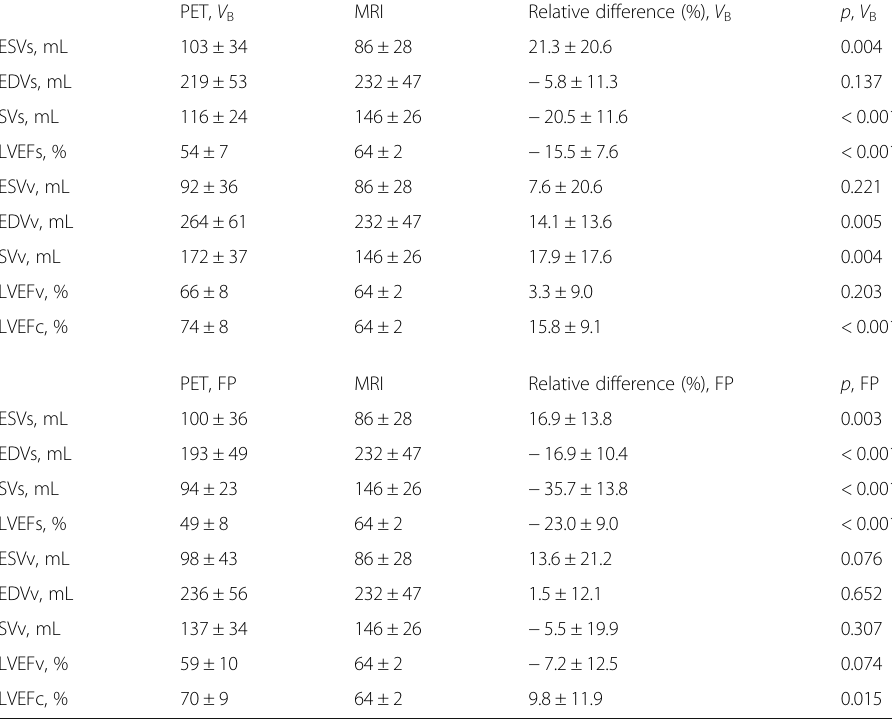
Table 5 Excluding outliers, average LV volumes and LVEF calculated from PET using surface- (s), count- (c) and volume-based (v) methods compared with average values from